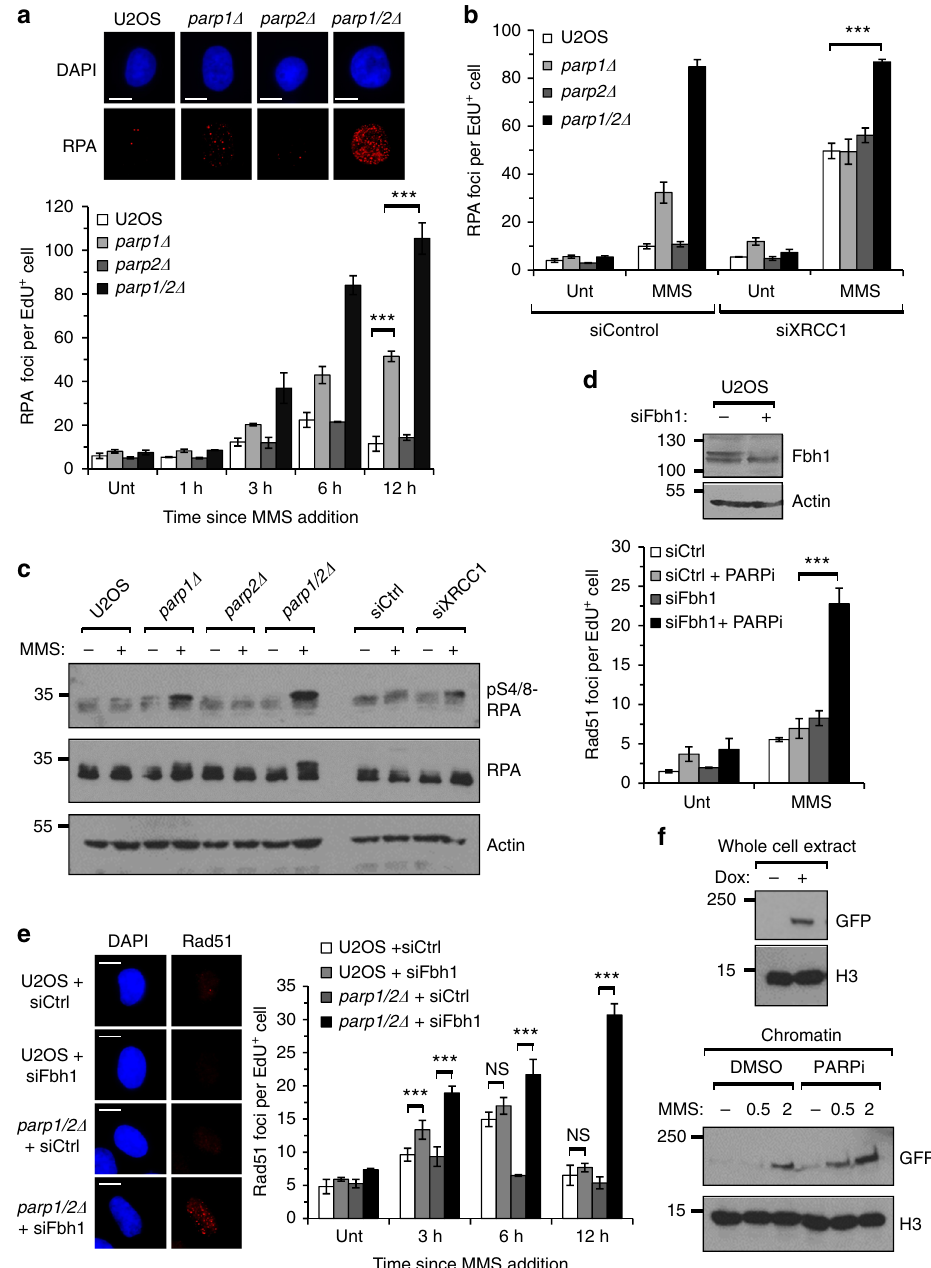
Fig. 5 PARP1 and PARP2 are required to stabilise Rad51 at stalled and/or damaged replication forks. a The indicated cell lines were treated with 1 μ M EdU (Unt), or with 1 μ M EdU and 0.5 mM MMS for 1 h before recovery in fresh media, and RPA foci quanti fi ed in EdU-positive cells. Times indicated show